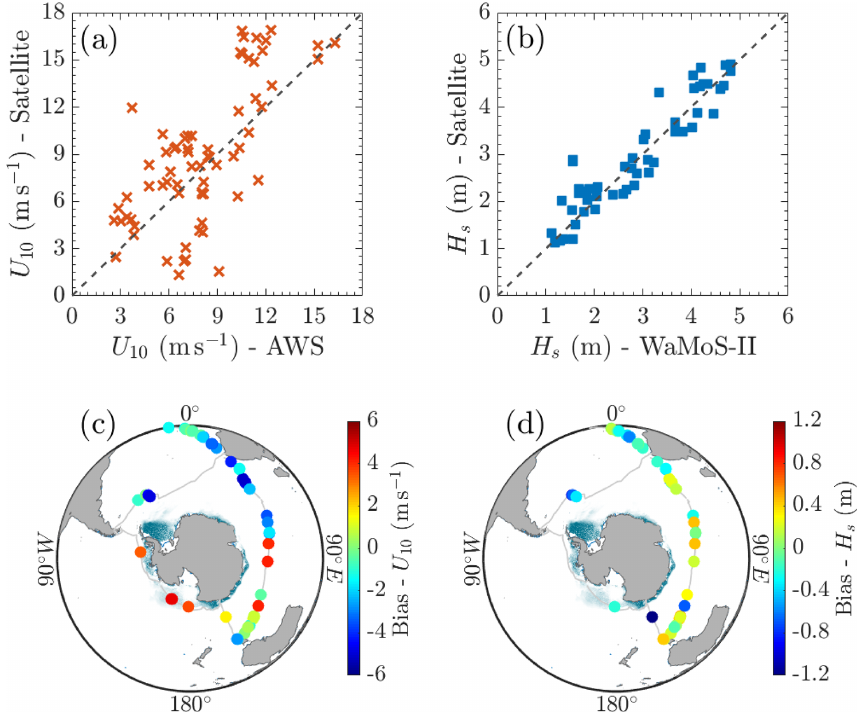
Figure 8. Wind from the automated weather station and significant wave height from WaMoS-II versus satellite observations: scatter dia- grams (a, b) and geographical distribution of biases (c, d) . Average sea ice concentration during the expedition is overlaid in panels (c) and (d)